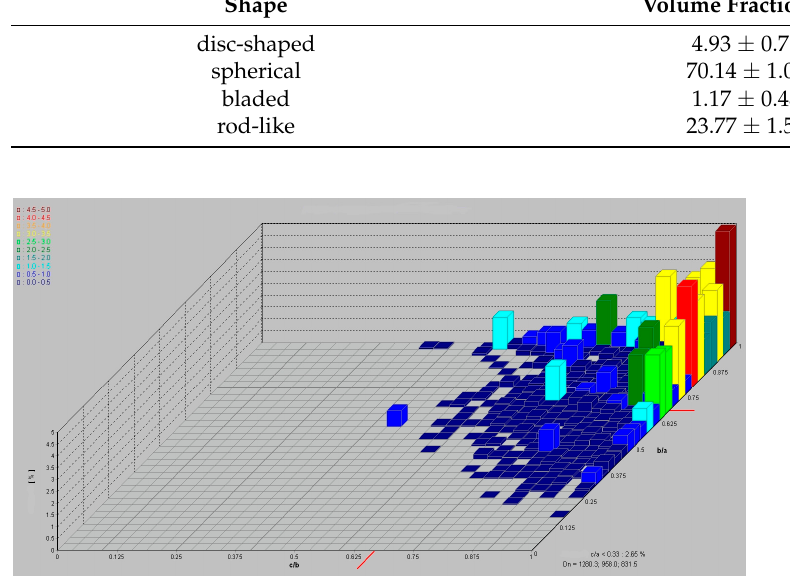
Figure 1. Shapes of shavings (in accordance with Zingg ′ s classification). Table 2. Chemical composition of shavings—content of elements in a sample (mg/kg), ND—below the limit of detection.